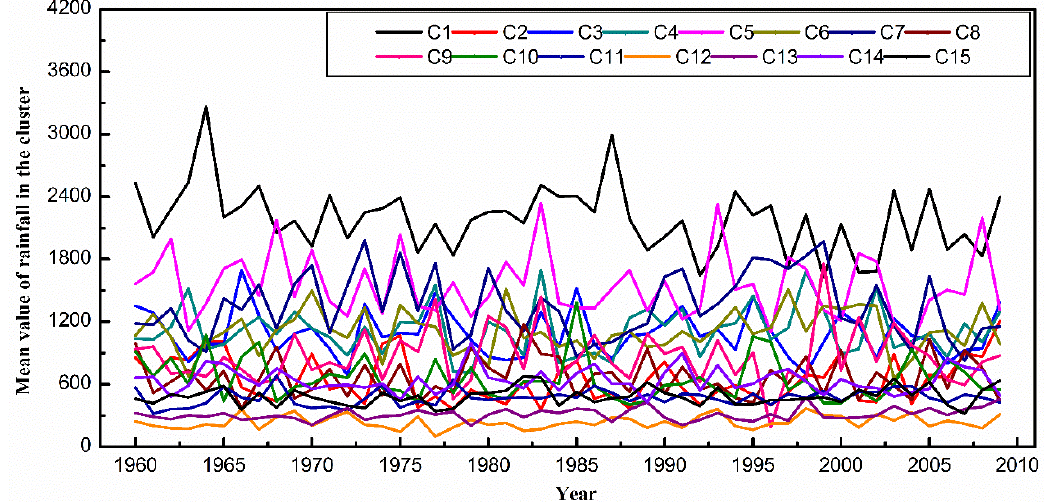
Figure 19. Mean values of clusters of rainfall in Figure 18. ISPRS Int. J. Geo-Inf. 2016 , 5 , 205